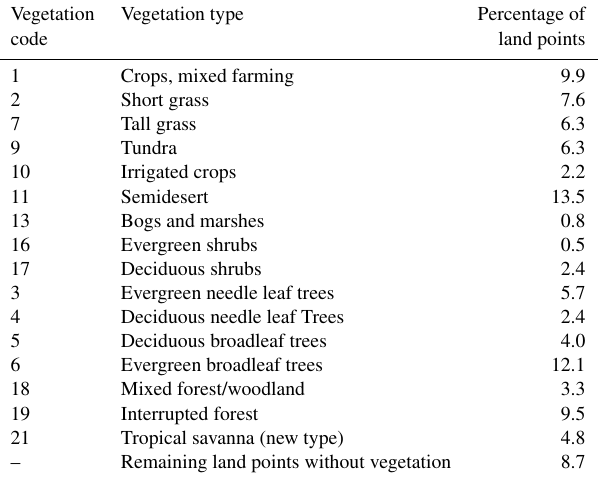
Table 1. Percentage of land grid points at model resolution TL255 ( ∼ 80km) for each dominant vegetation type, i.e. more than half of the grid point is covered by that vegetation type. A land grid point is defined by a land sea mask value greater than